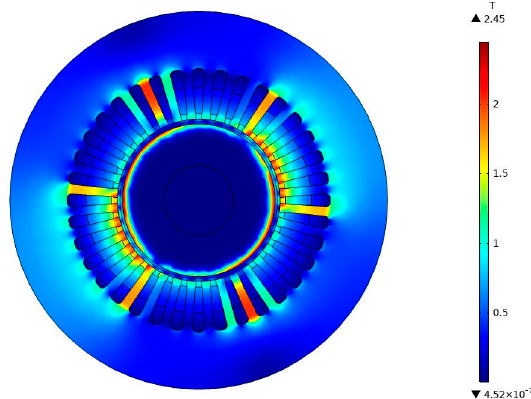
Figure 4. Magnetic flux density distribution in the motor cross-section from the electromagnetic finite element method (FEM) . element method